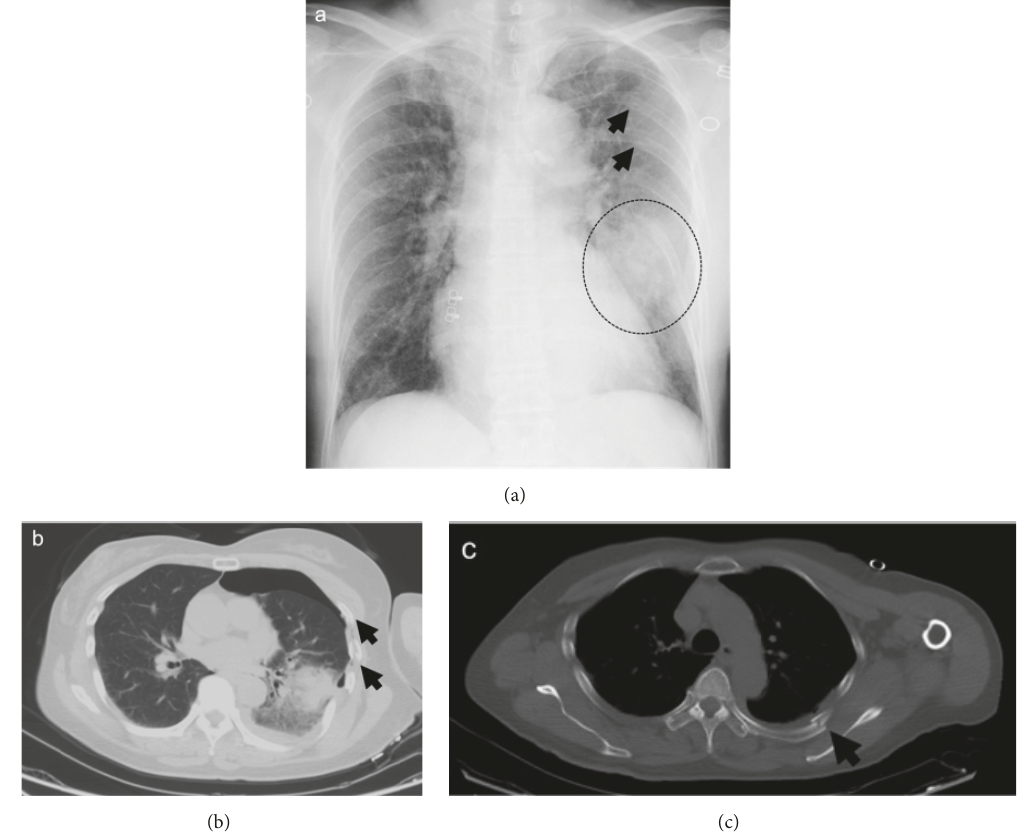
Figure 2: (a) Chest roentgenogram showing pulmonary contusion (dotted circle) with rib fractures (black arrows). (b and c) Chest CT showing left hemopneumothorax and pulmonary contusion with multiple rib fractures (black arrows).